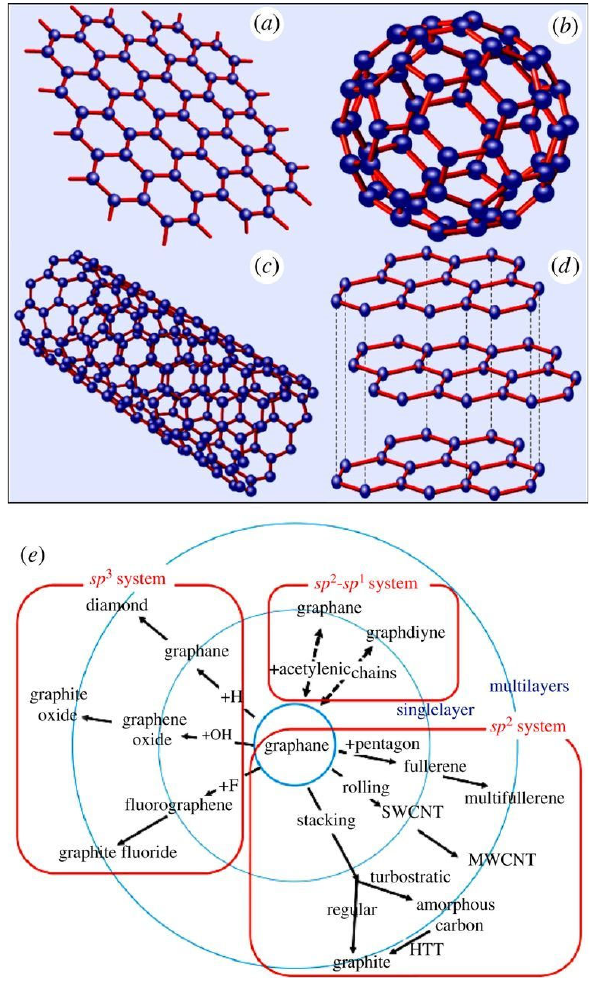
Figure 1. Schematic structures of ( a ) graphene (2 dimensions), ( b ) fullerene molecule (0 dimen- sions), ( c ) carbon nanotubes (1 dimension), ( d ) graphite (3 dimensions); ( e ) schematic of different carbonaceous derivatives including diamond